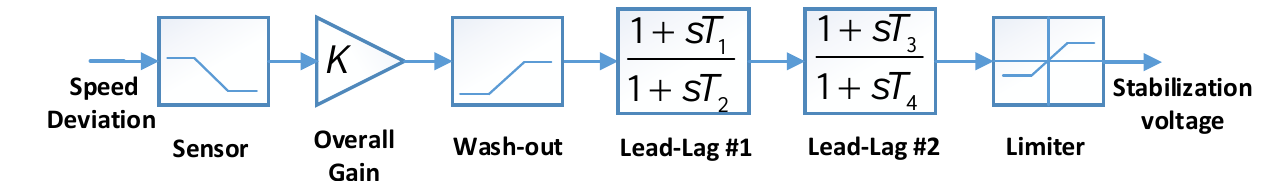
Figure 3. Block diagram representation of the generic power system stabiliser (PSS).